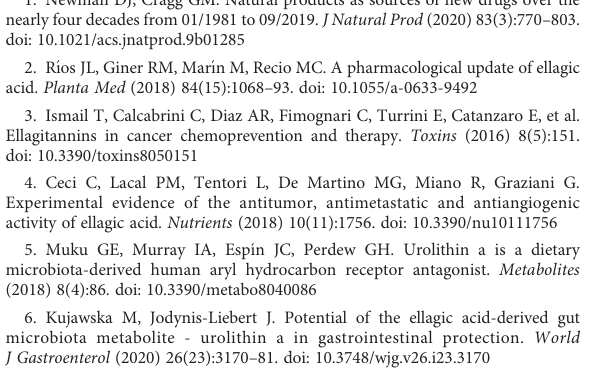
SUPPLEMENTARY FIGURE 1 UA treatment inhibits cell proliferation and induces G2/M phase cell cycle arrest in cholangiocarcinoma cell lines. HuCCT-1 and SSP-25 cells were treated with 0 or 40 m mol/L UA for 24 and 72 h. Cell cycles were determined using fl ow cytometry. Data represent the means of three independent experiments. Bars, standard deviation; **P < 0.01. SUPPLEMENTARY FIGURE 2 Positive control for the apoptosis assay. HuCCT-1 cells were treated with 30 m mol/L Camptothecin for 24 h, and then stained with annexin-V FITC and PI. Apoptosis cells were evaluated using fl ow cytometry. SUPPLEMENTARY FIGURE 3 Effects of UA on apoptosis progression. HuCCT-1 cells were treated with 0 or 40 m mol/L UA for 48 or 72 h, and then stained with annexin-V FITC and PI. Apoptosis cells were evaluated using fl ow